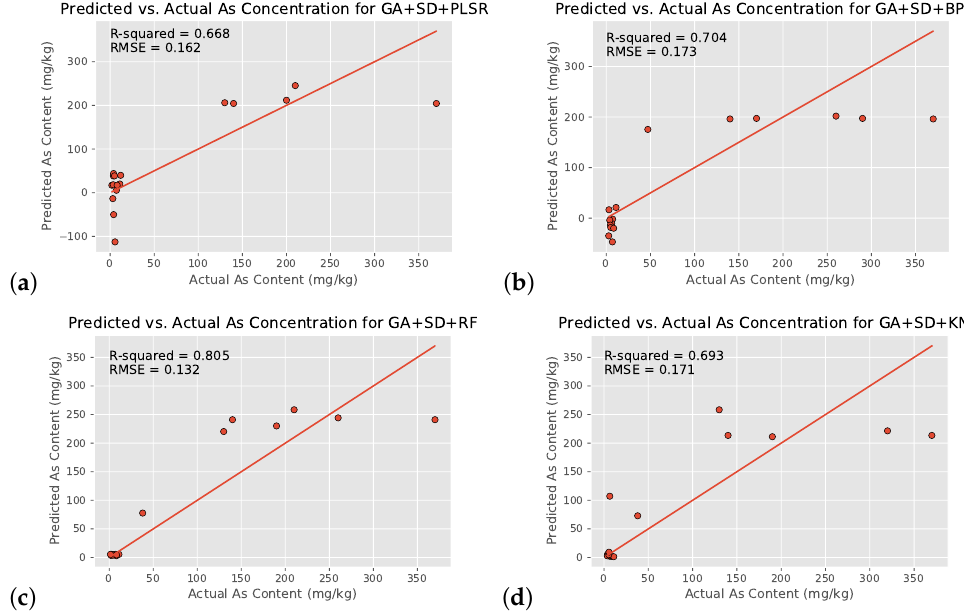
Figure 9. Same as Figure 8 but with GA-Generated 10 input wavelengths and SD transformation (GA + SD + Reg models): PLSR (control group, ( a )), BPNN ( b ), RF ( c ), and KNN ( d ).